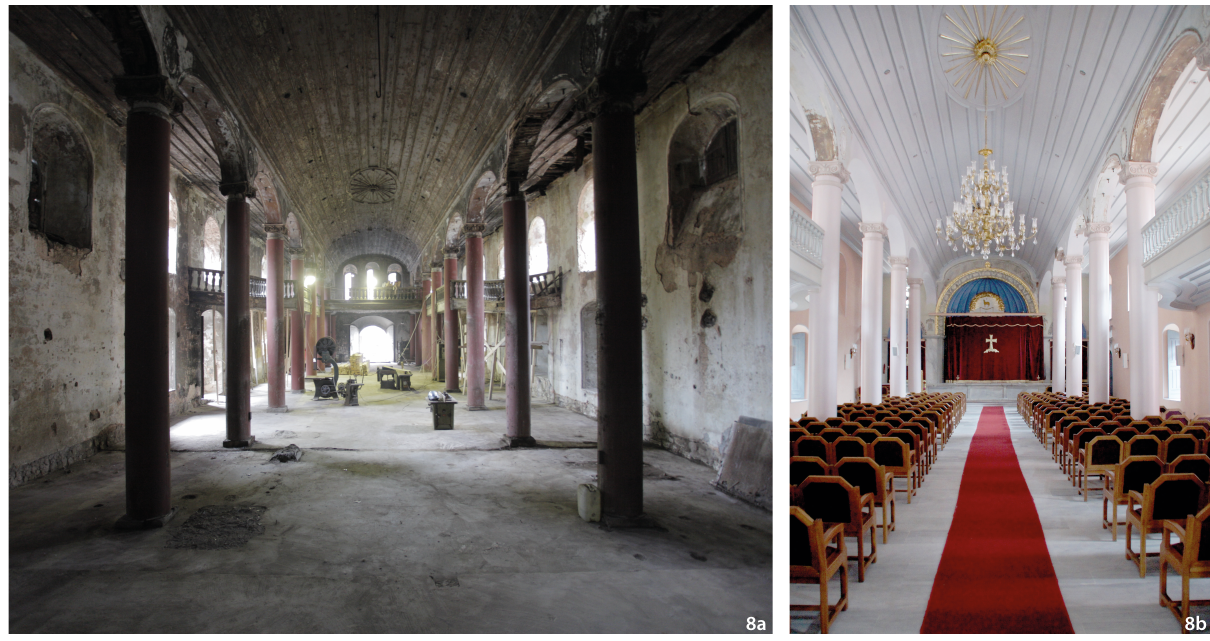
Figure 8a The Vortvots Vordoman Cultural Centre before the restoration in 2010 (Source: Kevork Özkaragöz). Figure 8b The Vortvots Vordoman Cultural Centre following the restoration in 2010 (Source: the